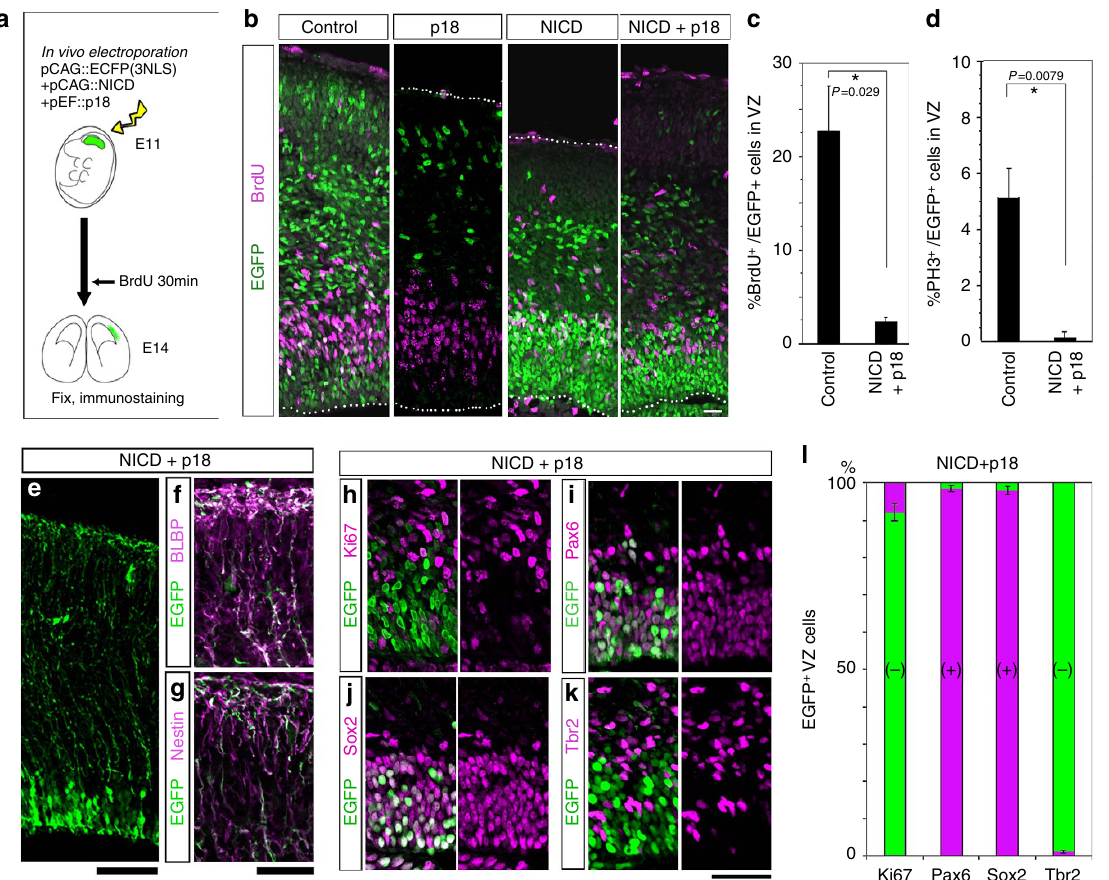
Figure 5 | Co-electroporation of Cdk inhibitor p18 and NICD inhibit cell-cycle progression of progenitors while maintaining them in an undifferentiated state. ( a ) Experimental design. pCAG::EGFP-3NLS alone (control), or with pCAG::NICD, or with both pCAG::NICD and pEF::p18 was electroporated into E11 cerebral wall in vivo . At E14, BrdU was administered for 30min, and brains were fixed and stained with antibodies to EGFP, BrdU ( b , c ), PH3 ( d ), BLBP ( f ), Nestin ( g ), Ki67 ( h ), Pax6 ( i ), Sox2 ( j ) or Tbr2 ( k ). ( c , d ) Frequency of BrdU þ cells ( c ) or PH3 þ cells ( d ) in the EGFP þ VZ cells was significantly reduced relative to the control by NICD/p18 co-overexpression ( c , N ¼ 4 for each case; d , N ¼ 5 for each case; Mann–Whitney U test, means ± s.d.). The characterization of the EGFP þ cells in the IZ/SVZ and CP is presented in Supplementary Fig. 11. ( e – g ) NICD/p18 co-expressing cells have radially elongated fibres that are positive for BLBP and Nestin. pCAG::EGFP, pCAG::NICD and pEF::p18 were co-electroporated on E11, and the brains were examined at E14. ( h – l ) Most of the NICD/p18 co-expressing cells in the VZ are negative for Ki67 and Tbr2 and positive for Pax6 and Sox2. Bars, 20 m m in ( b ), 60 m m in ( e